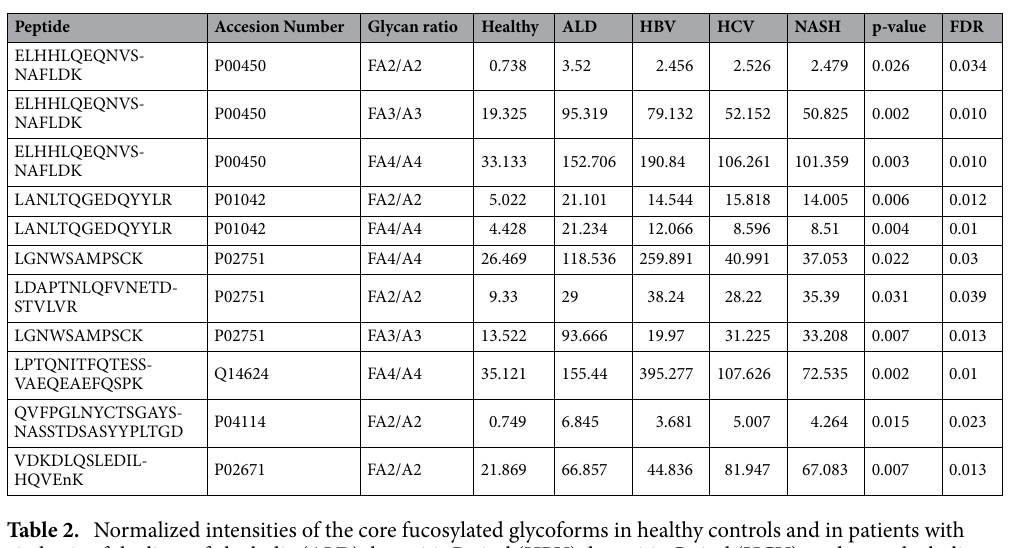
Table 2. Normalized intensities of the core fucosylated glycoforms in healthy controls and in patients with cirrhosis of the liver of alcoholic (ALD), hepatitis B viral (HBV), hepatitis C viral (HCV), and non-alcoholi steatohepatitis (NASH) etiologies for glycopeptides with ratio of the glycoforms increased more than threefold in at least two categories of the cirrhotic liver disease compared to the healthy controls. FAn/An: ratio of the fucosylated glycopeptide to the nonfucosylated glycopeptide, n = number of anntenas. FDR represents the false discovery